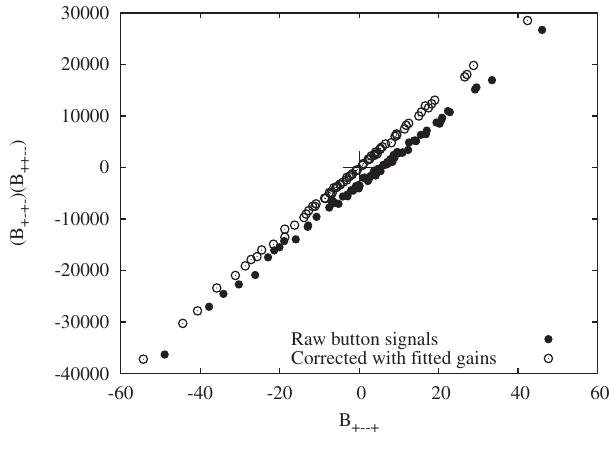
FIG. 9. B þ(cid:3)þ(cid:3) B þþ(cid:3)(cid:3) vs B þ(cid:3)(cid:3)þ for CESR BPM (#21E). There are 75 measurements distributed on a grid. The filled circles are the raw data. The open circles are the data corrected with the fitted gains. The fitted gains are g ð 1:4 Þ ¼ 0 : 993 ; 0 : 999 ; 1 : 020 ; 0 : 988 . The þ indicates the coordinate (0,0). Note that the fit eliminates the offset from